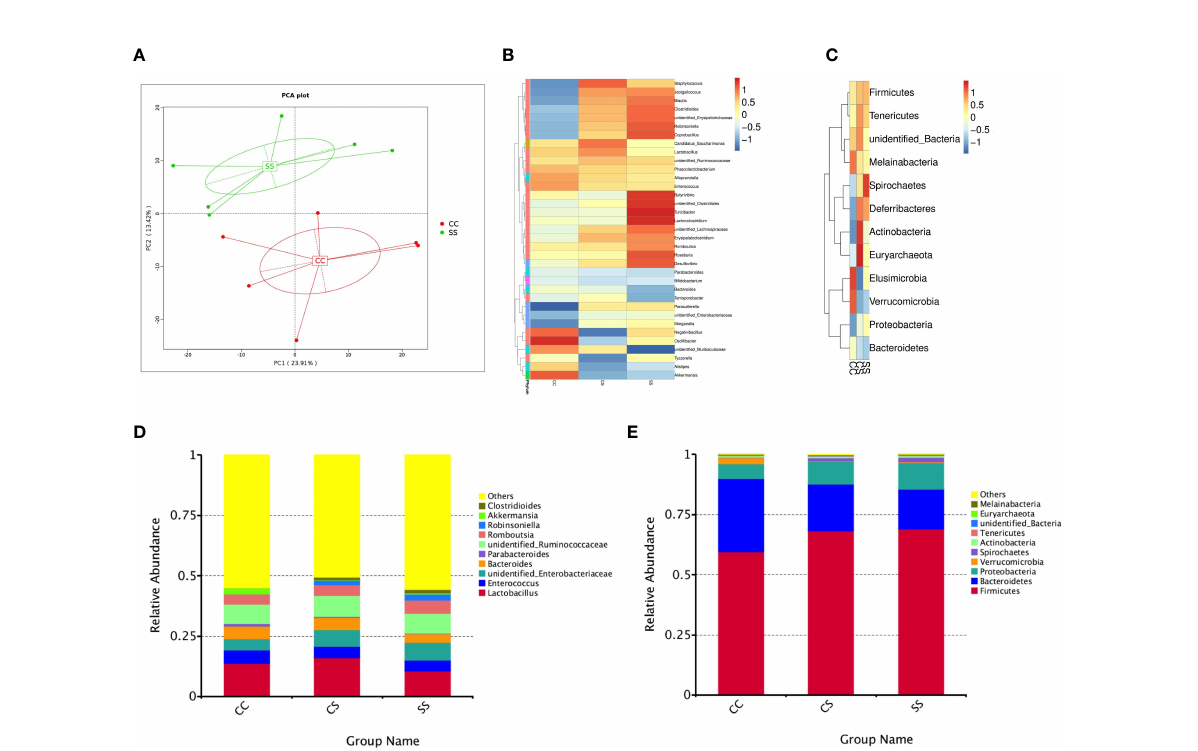
FIGURE 3 Anesthesia/surgery induced changes in gut microbiota in rats with preoperative stress (A) OUTs-based principal component analysis (PCA) from CC and SS group (n = 6/group). (B, C) Heatmap of bacterial communities at the genus level (B) and phylum level (C) for rats in the three groups (n = 6/ group). (D, E) Top 10 species with the largest relative abundance at the genus level (D) and phylum level (E) for rats in the three groups (n = 6/ group). CC, no stress; CS, only anesthesia/ surgery stress; SS, preoperative stress and anesthesia/surgery